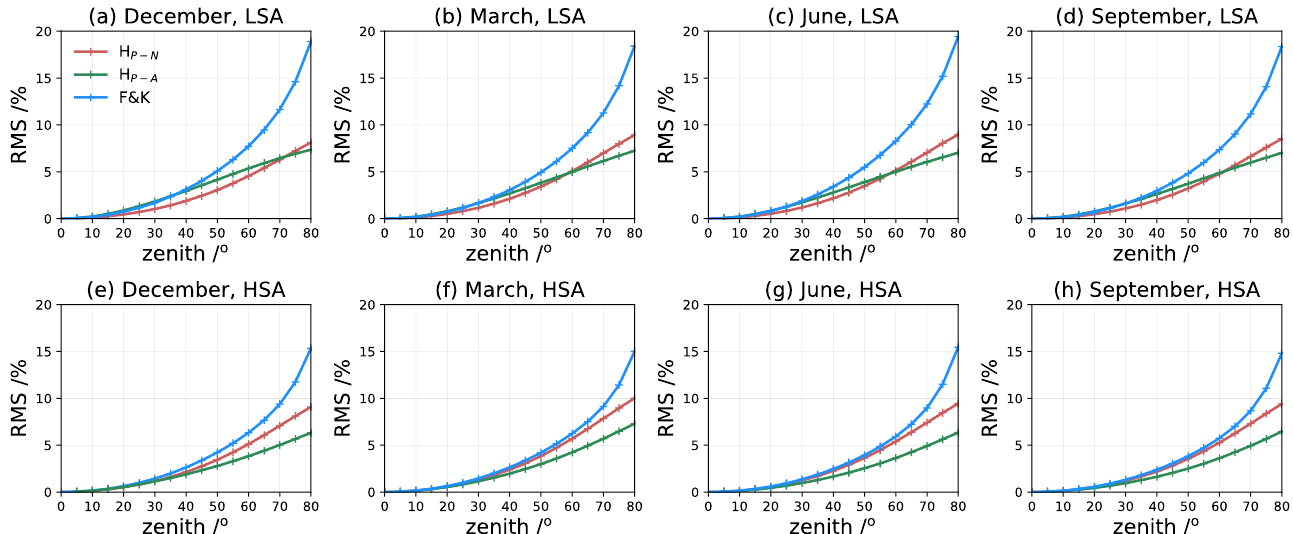
Figure 5. The relative RMS statistics of the scale-height-based mapping function with numerical and analytical solutions (denoted as ‘ H P _ N ’ and ‘ H P _ A ’, respectively), and the F&K model (‘F&K’) in four seasons under low and high solar activity conditions (represented by ‘LSA’ and ‘HSA’); panels ( a – d ) are for the LSA year, and ( e – h ) are for HSA year.